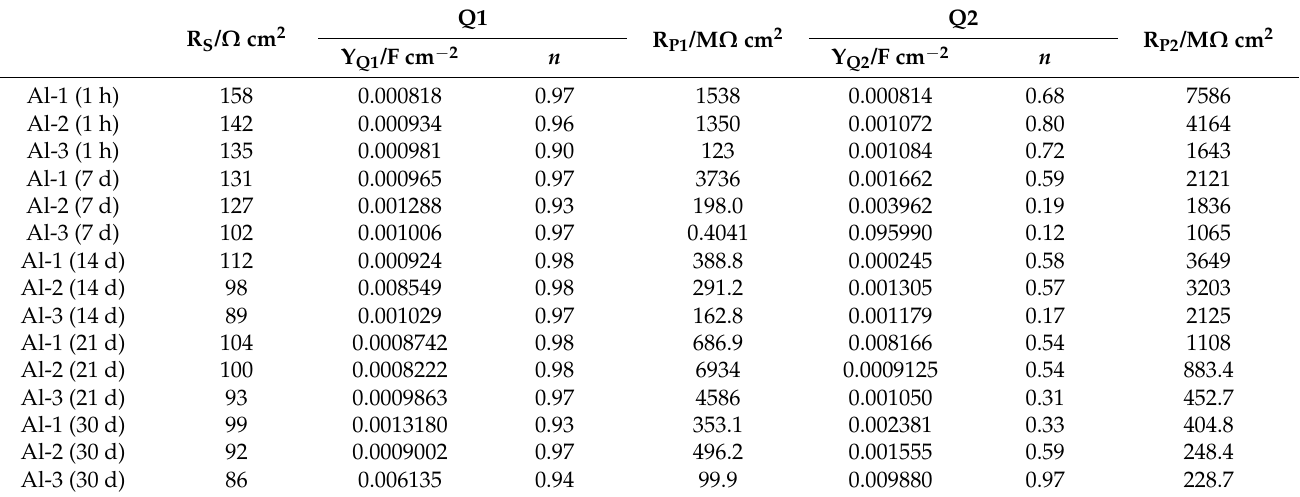
Table 5. Parameters obtained from fi tt ing the impedance data.